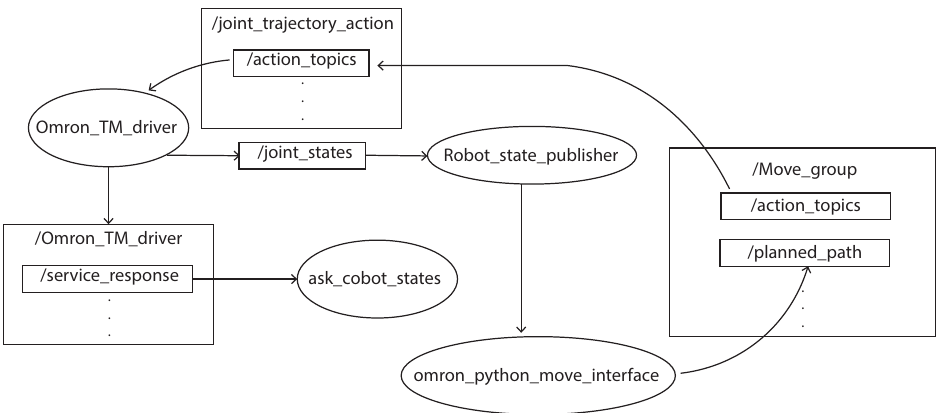
Figure 8. Schematic view representing the interaction between the principal ROS nodes involved in the proposed application. The nodes are circled, while inside the squares are specified on the top of the nodes’ names with relative topics or